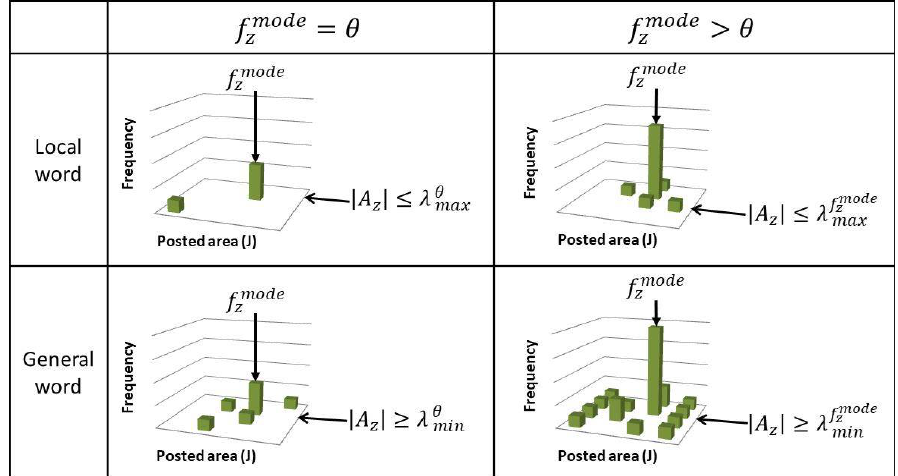
Figure 3. How the area-based frequency histogram of the word u z is used to determine if u z is a local or a general word. Intuitively, by using the same thresholds R and r for SL z , the thresholds representing the maximum and minimum number of areas λ f are changed according to the peak f mode z of the frequency